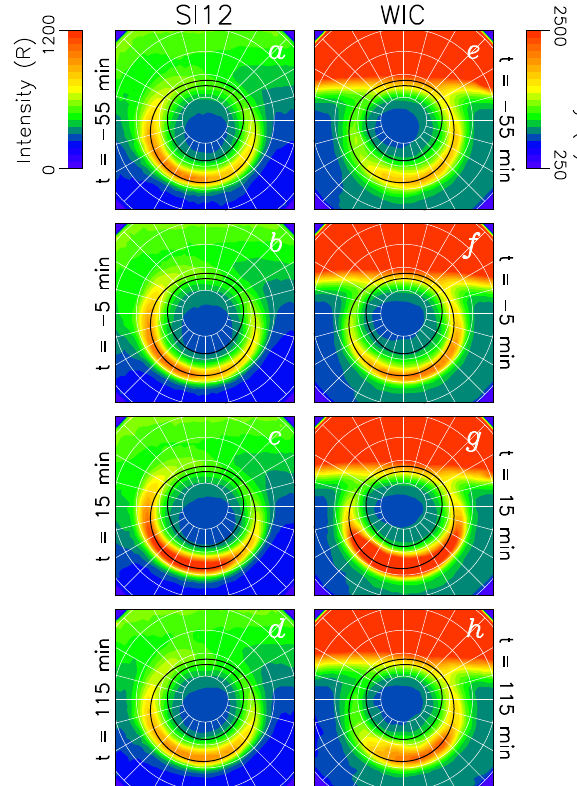
Fig. 3. A selection of SI12 and WIC average auroral images for cat- egory IV substorms. The data are presented in a polar geomagnetic latitude and MLT frame, with 12:00MLT to the top of each image. Radial lines indicate MLT meridians and concentric circles are lines of constant geomagnetic latitude in steps of 10 ◦ . Superimposed on each image is a K P =3 Feldstein and Starkov (1967) average auroral oval.